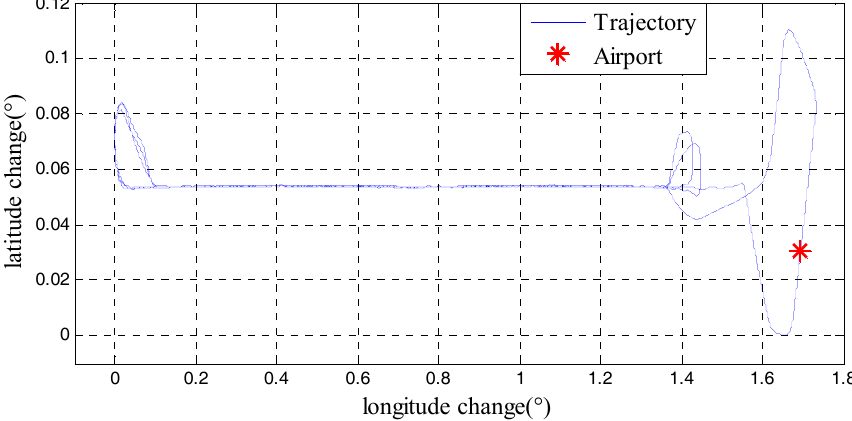
Figure 14. Trajectory of Neimeng flight. Sensors 2018 , 18 , x FOR PEER REVIEW